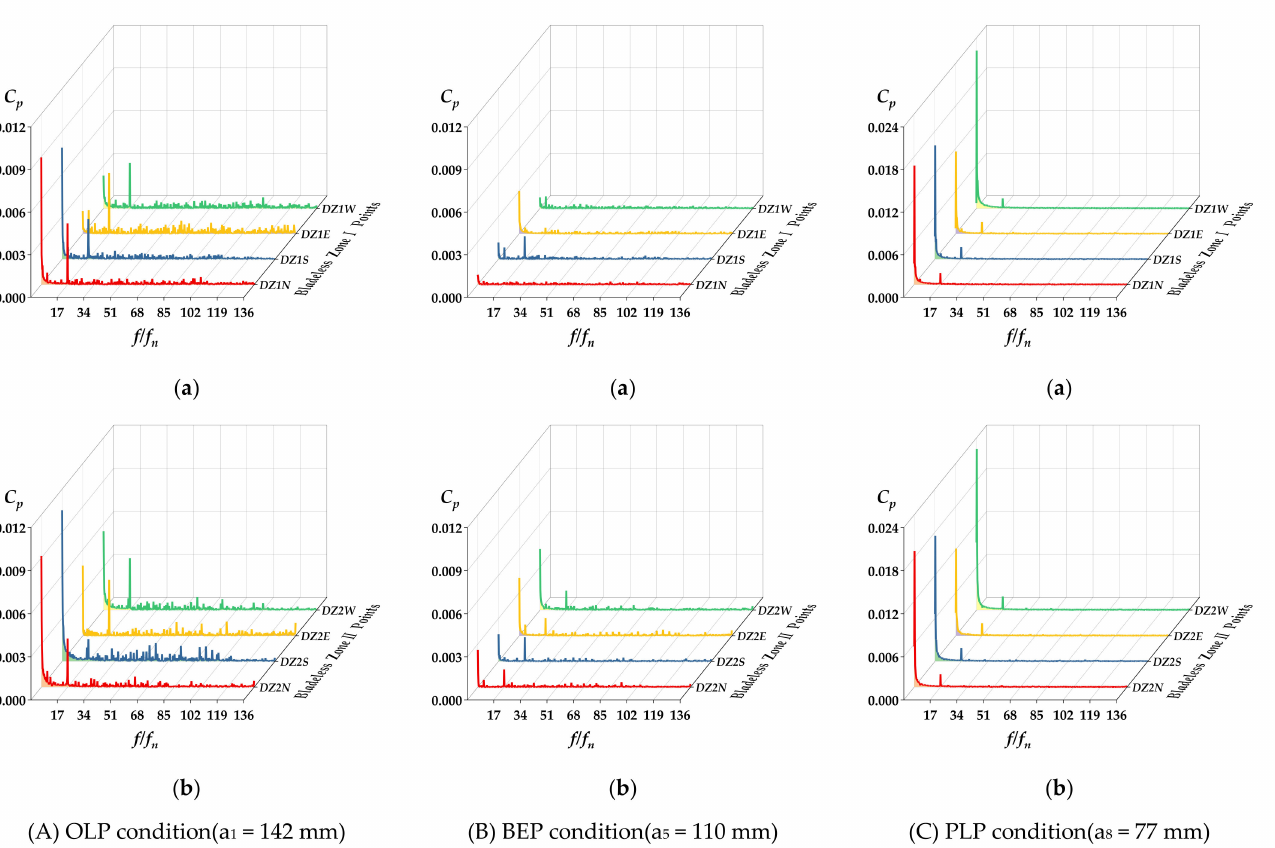
Figure 18. Spectrum of pressure pulsation at bladeless zone monitoring points under different working conditions. ( a ) Data from bladeless zone of the runner I side; ( b ) data from bladeless zone of the runner II